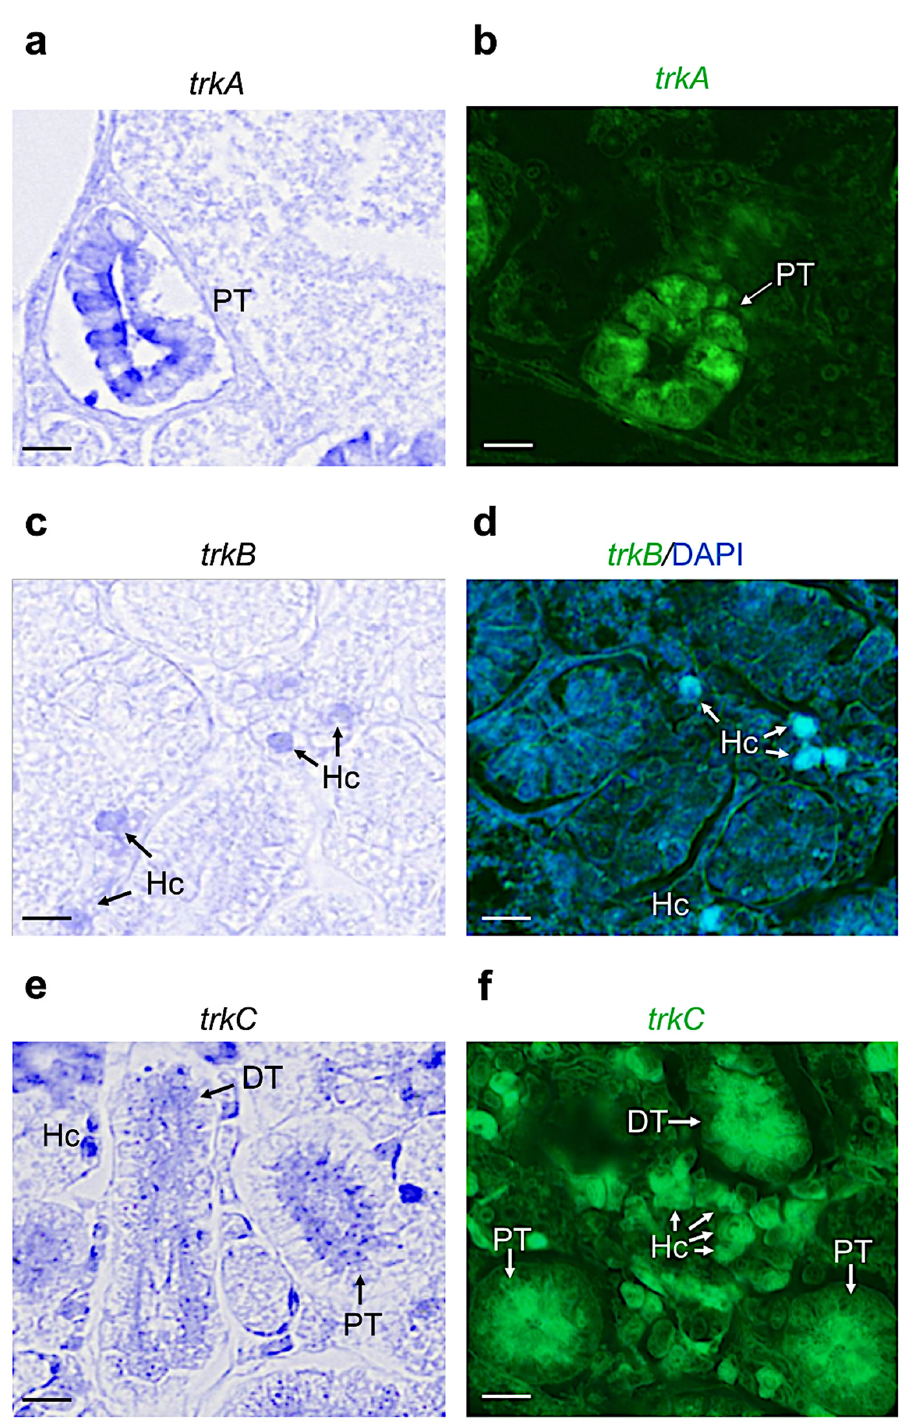
Figure 4. Chromogenic and fluorescence in situ hybridization for tyrosine kinase receptors trka , trkb , and trkc on cryostat and paraffin sections of adult zebrafish kidney. ( a ) Chromogenic and ( b ) fluorescence in situ hybridization of trkA-mRNA in adult zebrafish kidney; it is expressed in proximal tubules (PT). ( c ) Chromogenic and ( d ) fluorescence in situ hybridization of trKB - mRNA and cell nuclei marked with DAPI staining in adult zebrafish kidney; trkb is expressed in hematopoietic cells (Hc). ( e ) Chromogenic and ( f ) fluorescence in situ hybridization of trkC-mRNA ; it is expressed in hematopoietic cells, and proximal and distal tubules (respectively, Hc, PT, and DT). Scale bars: 100 µ m ( a – f